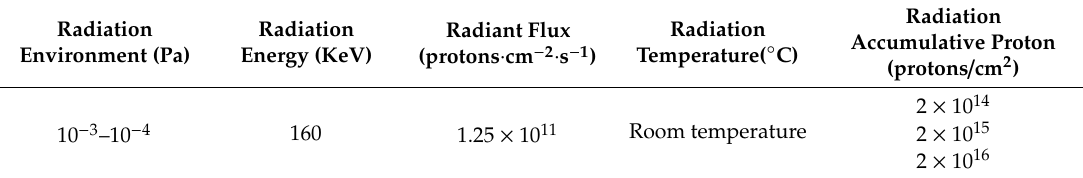
Figure 2. Clamping fixture holding the specimens during proton irradiation. Table 3. The proton irradiation test